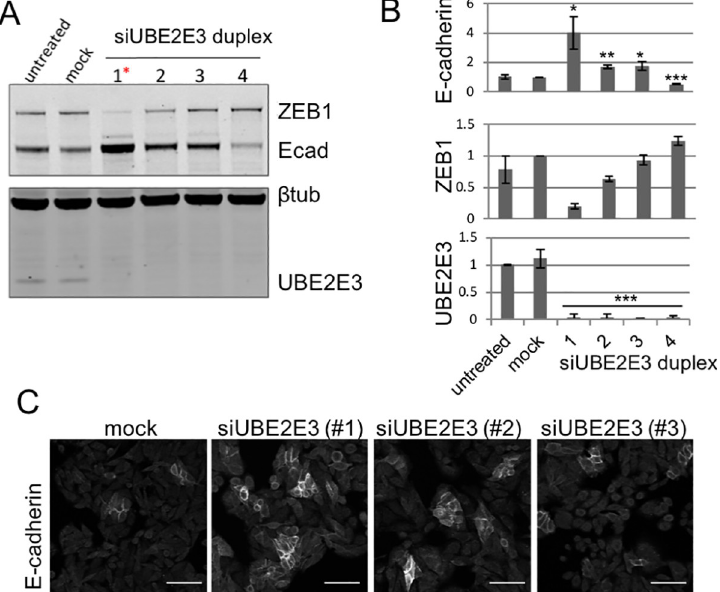
Fig 3. Effect of siUBE2E3 on SW480 membrane-associated E-cadherin. SW480 cells were transfected with individual siRNA duplexes from the UBE2E3 SMARTpool for 72 hours: (A) Expression of ZEB1, E-cadherin and UBE2E3 were analysed by immunoblot. β -tubulin was used as a loading control. siRNA#1 (1 � ) shares the same 5’ nucleotide sequence as miR200 family seed sequence. The blot is representative of three individual experiments. Shown are cropped images, uncropped blots are included in S1 Raw images; (B) Quantitation of E-cadherin, ZEB1 and UBE2E3 protein levels upon siUBE2E3 knockdown in SW480 cells. Protein levels were determined using densitometry against the loading control β -tubulin and are representative for triplicate experiments (mean ± SEM) � p < 0.05 (p = 0.026 and p = 0.039 for si UBE2E3 1 and 3, respectively), �� p < 0.005 (p = 0.00247), ��� p < 0.001 for E-cadherin and UBE2E3 or duplicate experiments (mean ± sd) for ZEB1 � p = 0.023, �� p = 0.0035, ��� p < 0.001; one-tailed unpaired t - test vs mock control; (C) Immunofluorescence staining of E-cadherin in fixed SW480 cells, 72 hours post treatment with si UBE2E3 siRNA duplexes #1, 2, 3 or mock control. Scale bar; 50 μ